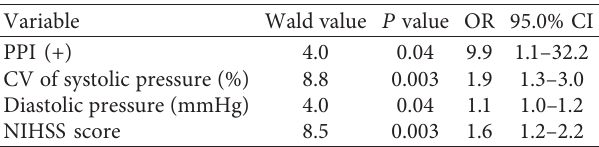
Table 4: Analysis of BA stenosis in the PPI and DPI groups. Groups Cases